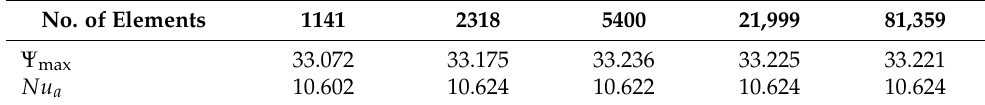
Table 2. Grid independence test for Re = 100, Ha = 0, φ = 4% and N = 4. No. of Elements 1141 2318 5400 Ψ